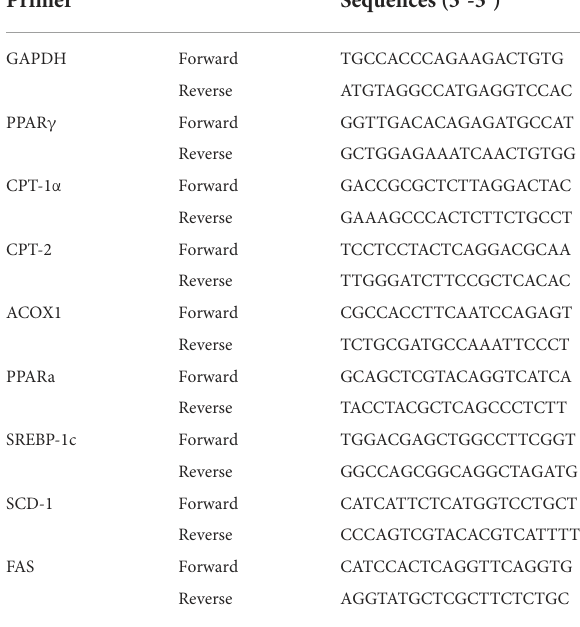
TABLE 1 The primers used for the polymerase chain reaction (PCR)